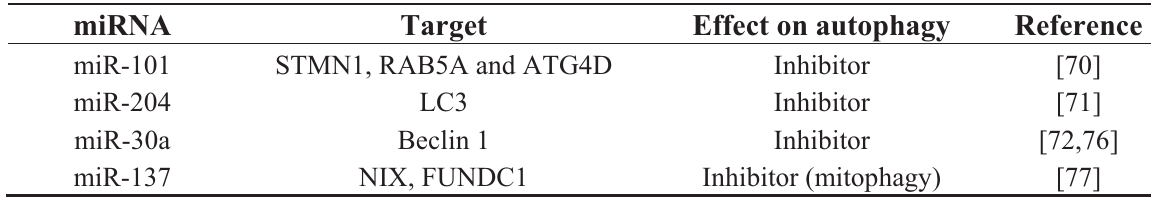
Table 2. Example of some miRNAs involved in the regulation of